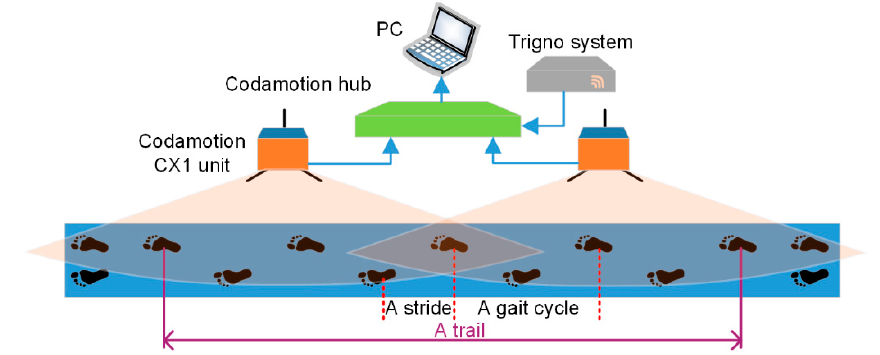
Figure 3. The schematic of the experiment.